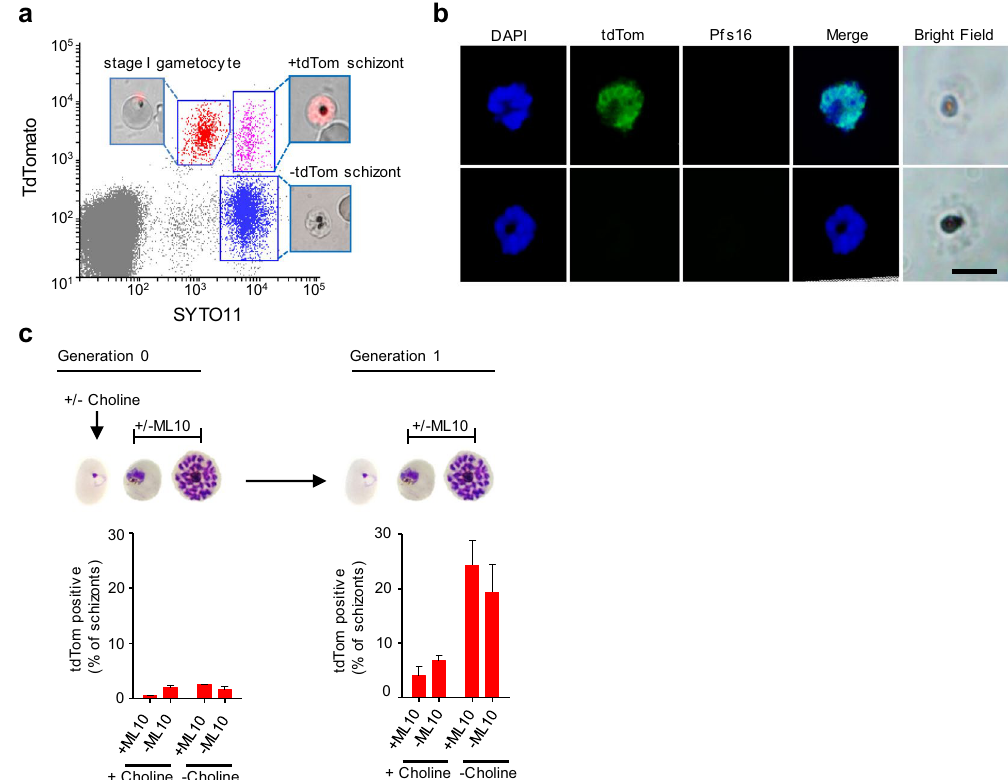
Figure 4. Expression of tdTom in schizonts of gexp02-Tom lines. ( a) Representative flow cytometry analysis of the NF54-gexp02-Tom line at ~48–53 hpi (induced by choline depletion at the previous cycle and treated with ML10), showing presence of tdTom-positive schizonts (upper right gate), in addition to stage I gametocytes (upper left gate), and tdTom negative schizonts (lower right gate). Insets are live cell fluorescence microscopy images of the different subpopulations. (b) Representative IFA images of schizonts that are either tdTom positive or negative. All schizonts were Pfs16-negative. Scale bar: 5 µ m. (c) Flow cytometry-based quantification of tdTom positive schizonts at the generation of induction and the following generation. Induced (choline- depleted) and uninduced (choline-supplemented) cultures, with or without addition of ML10, were tested. Data are presented as the average and s.e.m. of three independent biological